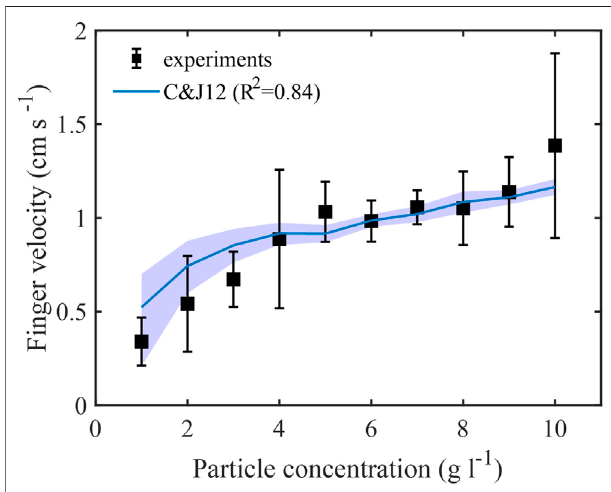
FIGURE 8 | Finger velocity as a function of initial particle concentration. The blue line corresponds to the fi nger velocity calculated using Eq 13 ; Hoyal et al., 1999b; Carazzo and Jellinek 2012) in combination with Eq. 12 toobtain the reduced gravity of the PBL. The blue region corresponds to fi nger velocities calculated with upper fl uid concentrations ranging from 0 (upper limit) to 7% (lower limit). Vertical error bars correspond to the standard deviation of the fi nger velocity measured in different